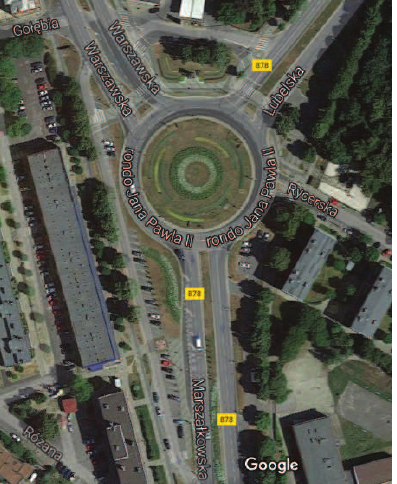
Fig. 1. A view of the selected